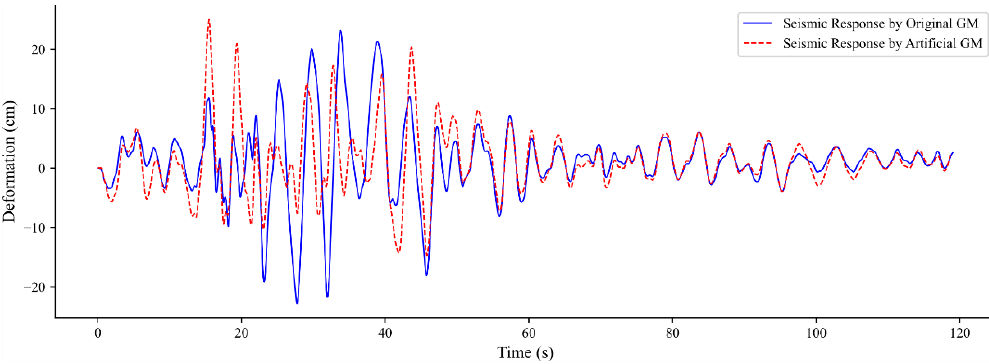
Figure 9. Vertical seismic responses of deformation of the target structure.